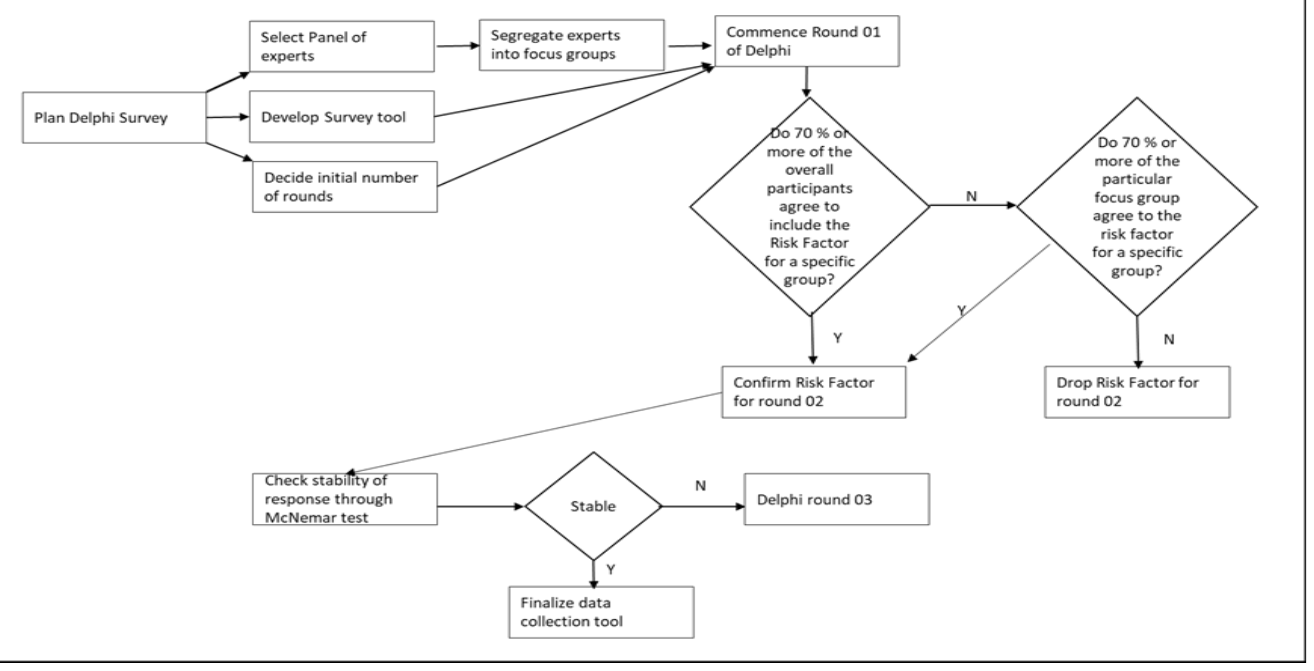
Fig. 1. Process for authentication of the contractual